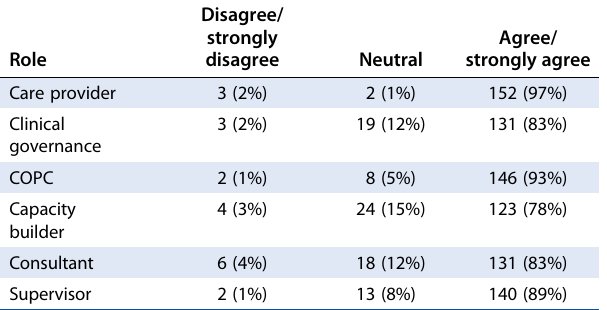
Table 2: Likert scale of the awareness of primary care programmes ( n =